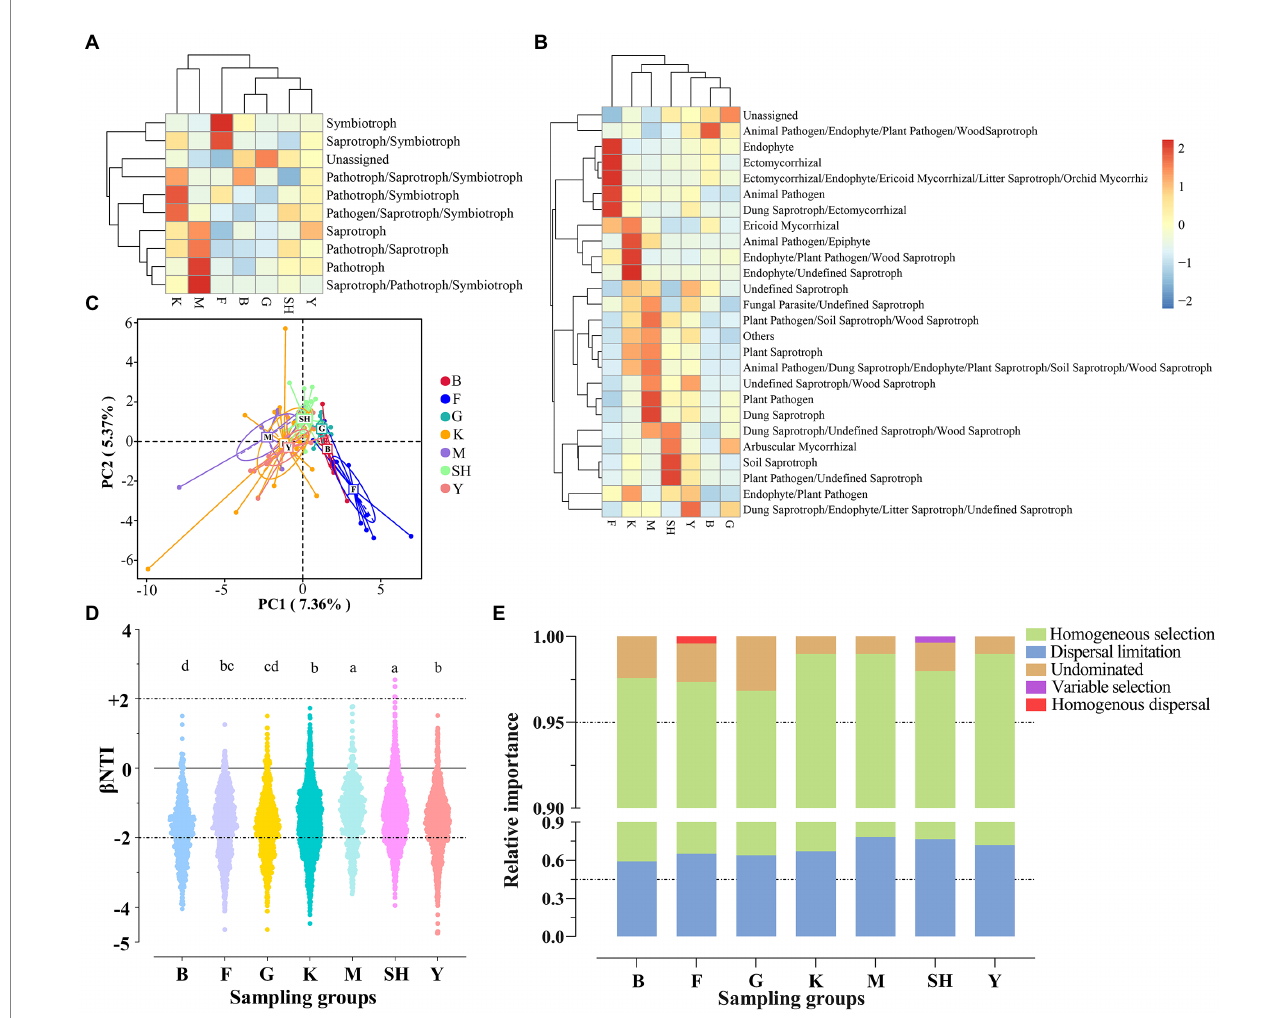
FIGURE 7 Assignment of the functional guild (functional group) using FUNGuild software. The FUNGuild ver 1.0 database was used to assign ecological functions, trophic modes (A) , and guilds (B) to each OTU. Variations of guilds among sampling sites (C) based on principal component analysis (PCA). Null model analysis reveals the value of β NTI (D) and the assembly mechanism of fungal communities across different sampling locations (E) . Abbreviations of variables are given in Figure 1. Lowercase letters significantly differ above each sampling group at p <